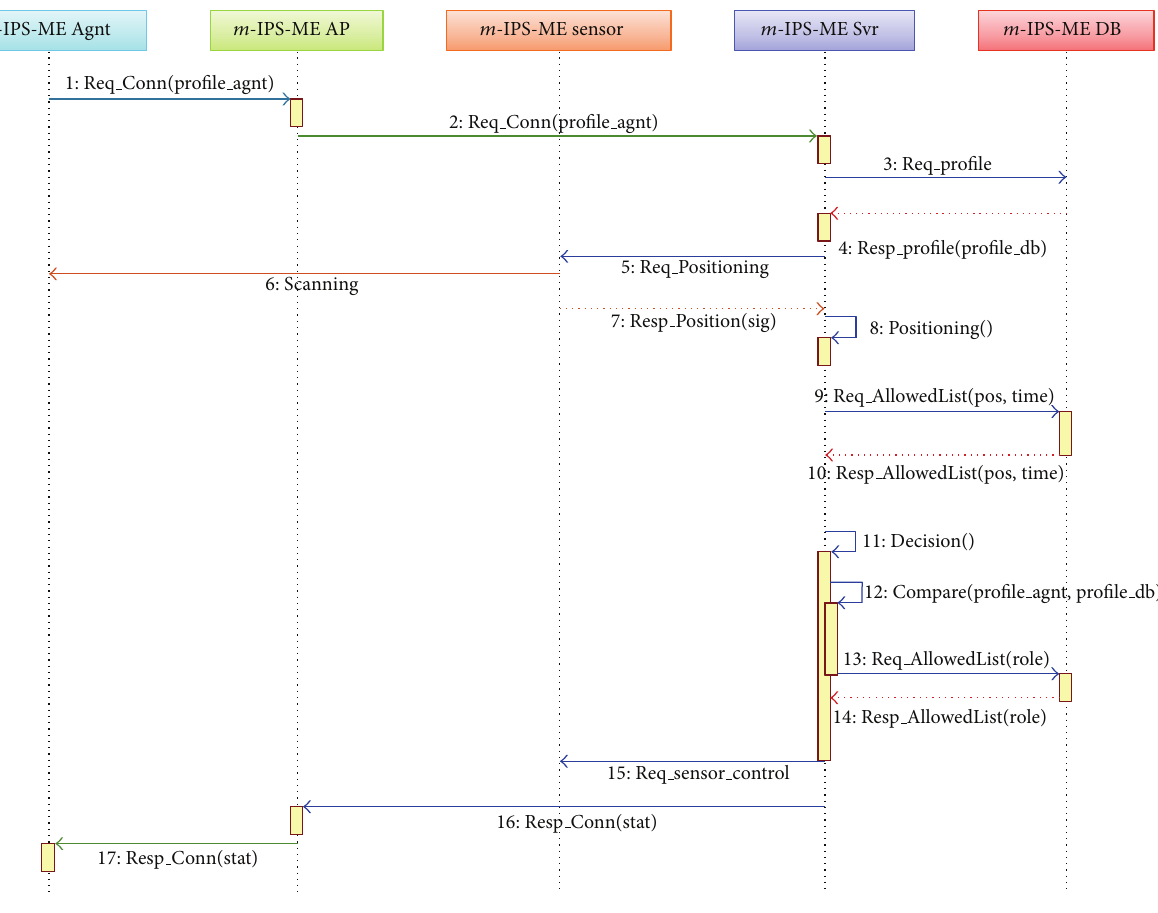
Figure 3: Service